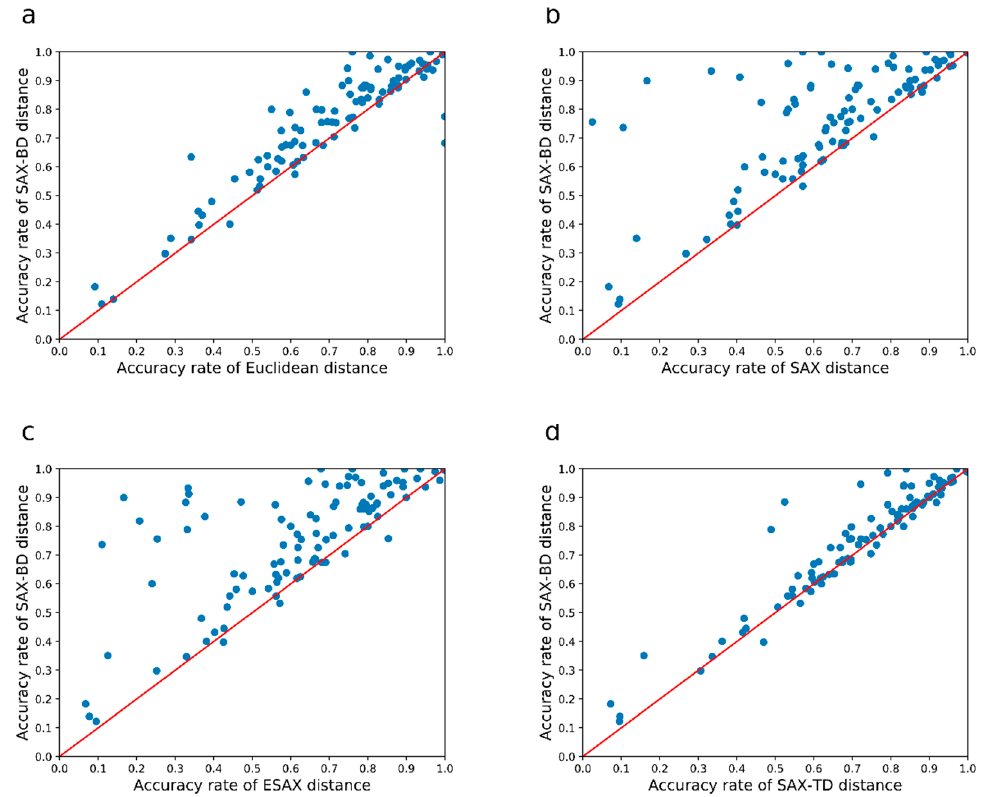
Figure 6. The SAX-BD algorithm is compared with other algorithms for accuracy. ( a – d ) represents a comparison between SAX-BD with Euclidean, SAX, ESAX, SAX-TD. The more dots above the red slash, the better performs of